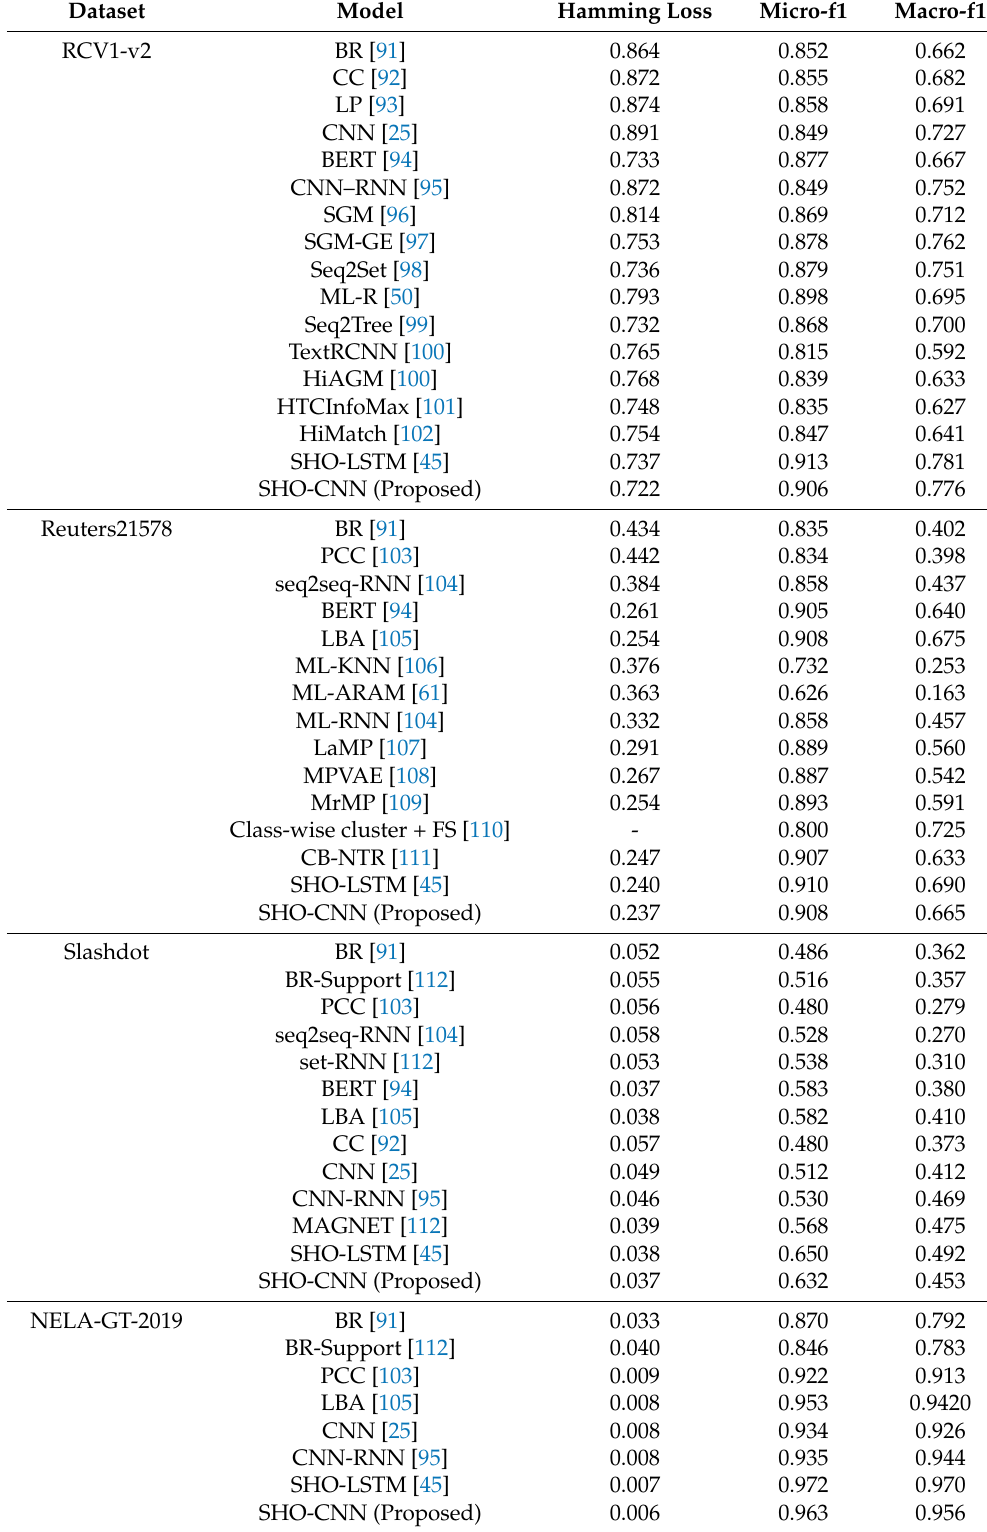
Table 6. Comparison between proposed model and similar